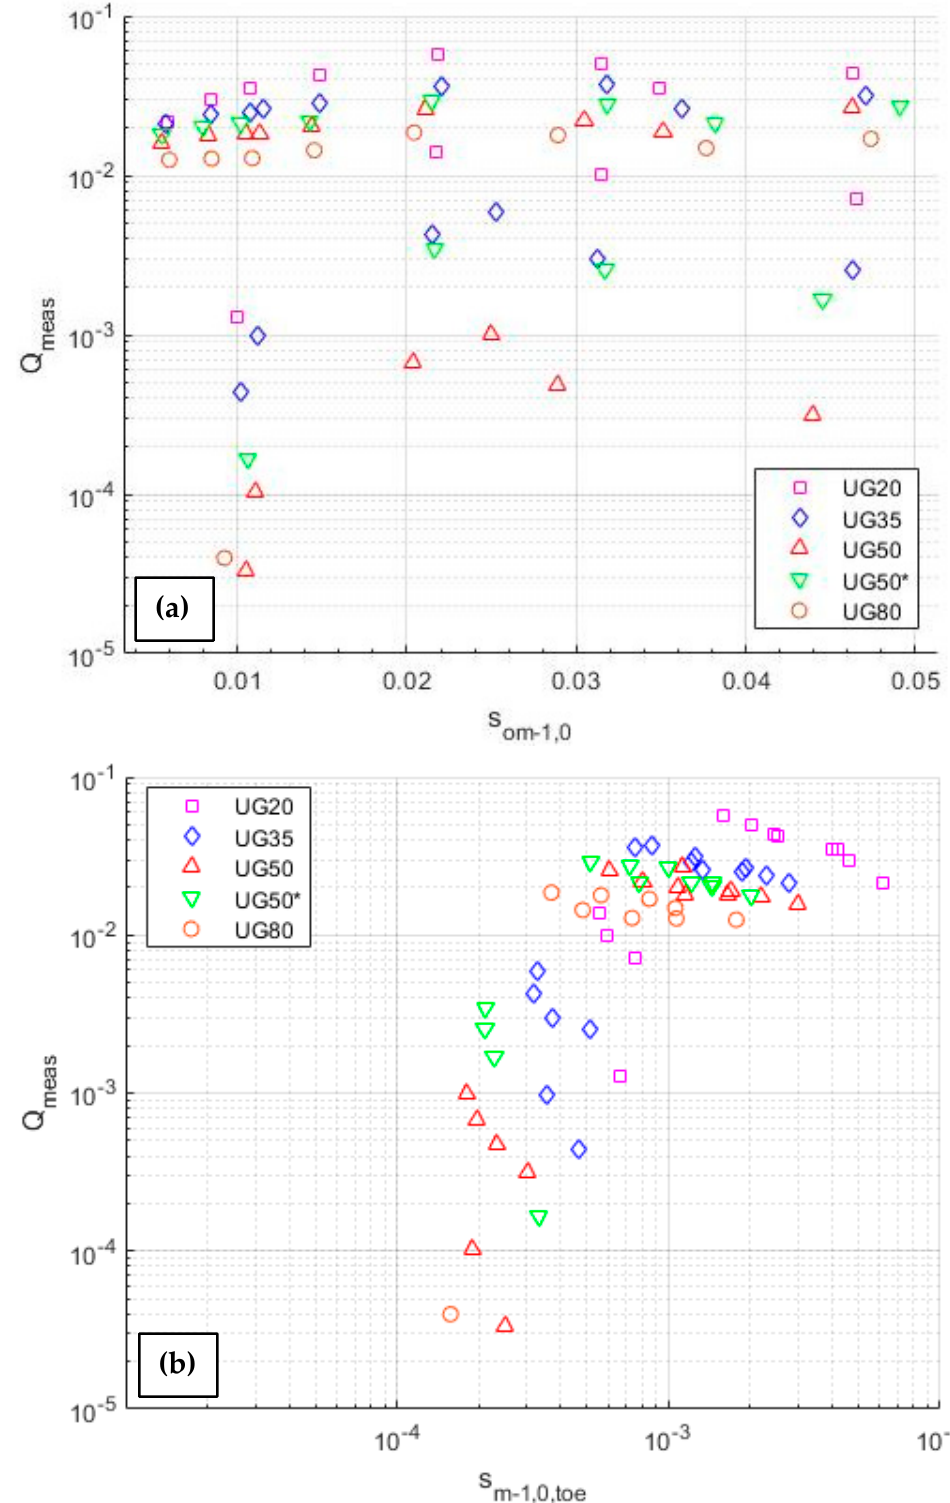
Figure 4. Variation in the dimensionless overtopping discharge versus ( a ) the deep-water steepness and ( b ) the wave steepness at the dike toe.